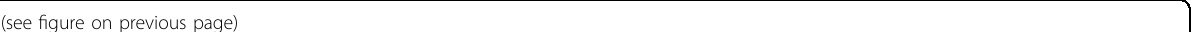
Fig. 2 Phosphoproteomic characterization of DYRK1A inhibition in U251 glioblastoma cells reveals CDK1 hyperactivity. A Design and summary of the phosphoproteomic analysis of U251 cells treated ± DYRK1A inhibitors L41 and ALGERNON (ALG) for 72 h, and U251 shDYR cells treated ± DOX. B Venn diagram showing overlap among phosphopeptides signi fi cantly (ANOVA adj. P < 0.05 and Dunnett ’ s P < 0.05) reregulated by DYRK1A pharmacological inhibition (5,970 total) and genetic knockdown (1792 total). C A consensus sequence preference for DYRK1A. Motif enrichment analysis of 61 phosphopeptides regulated by both pharmacological and genetic inhibition that also possess an Arginine (R) in the – 3 position, reveals a strong preference for Proline (P) in the + 1 position. D Heatmap of phosphopeptide intensities (median log2 fold changes for treatment vs their respective controls) for phosphopeptides identi fi ed as potential DYRK1A substrates. E Heatmap of protein changes (median log2 fold changes of protein LFQ intensities for treatments vs their respective controls) for proteins on which phosphosites from panel D are found. F Kinase perturbation analysis with Kinase PA showing relative kinase activity in z -scores from DOX 48 h vs No DOX treatments ( x -axis) and ALG (10 μ M) vs untreated treatments ( y -axis). G Kinase-substrate motif enrichment analysis for sites hyperphosphorylated in response to DYRK1A (DYR) inhibition. H Gene ontology over-representation analysis (Fischer ’ s exact test) of signi fi cantly hyperphosphorylated proteins in cells treated with ALG (10 μ M, 72 h). I Annotation of CDK1 substrates (derived from PhosphoSitePlus) in the phosphoproteome of cells treated with ALG (10 μ M, 72